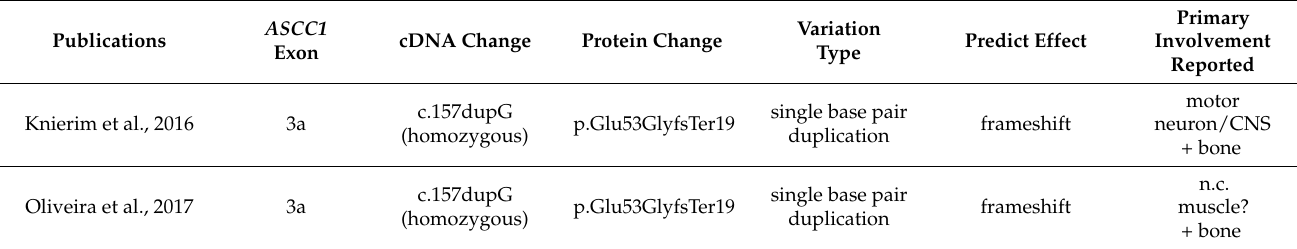
Table 2. Summary of the 7 ASCC1 mutations identified so far. Some patients were compound heterozygous (comp het) for a nonsense mutation associated with a nucleotide duplication (in exons 3a and 5, respectively) or with microdeletions (in exons 9a and 6-9a or in exons 5 and 9). The localization of the mutations reported in the table corresponds to those mentioned in each article. Authors generally used the exon nomenclature from the first description by Knierim et al. [23] with the exception of Lu et al. [35]; n.c: